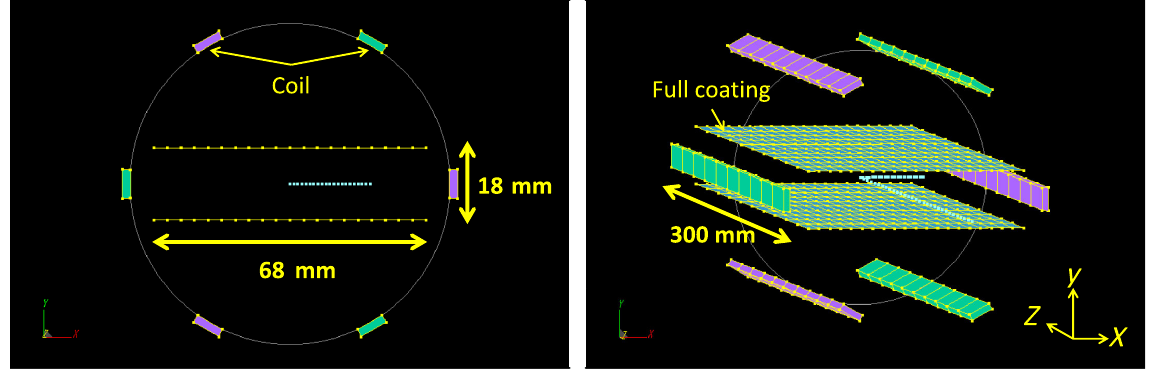
FIG. 8. Magnet modeling to optimize the parameters of the comb-tooth-shaped coating. The left-hand figure shows the cross-sectional structure of the coil and coating plate. The right-hand figure shows a three-dimensional view of their structure with a uniform coating. The light-blue dots on the x -axis and z -axis are the magnetic-field measurement points.